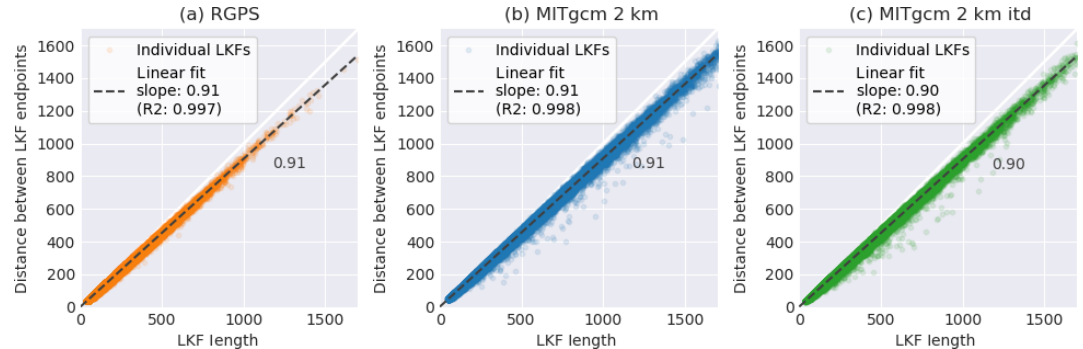
Figure 8. The distance between the endpoints of an LKF plotted over its length. We find that all observations fit a linear line. The slope of the fitted linear relationship is given next to the fitted line.